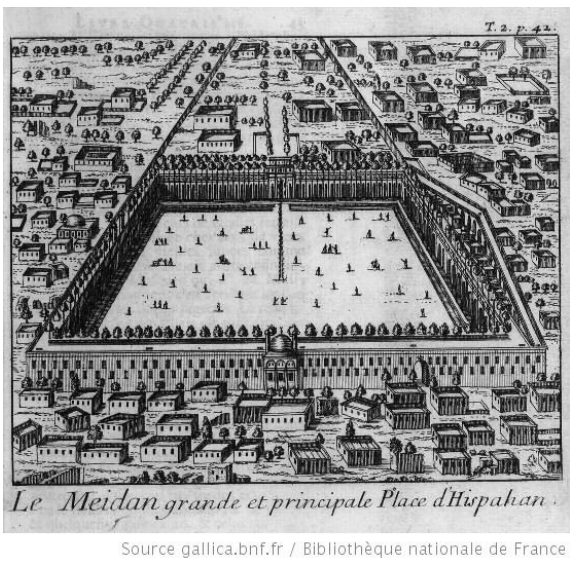
fig. 4. Engraving of the maydan naghsh-e jahan in Tavernier. The city square is a positive void in Isfahan Source: Bibliothèque nationale de france